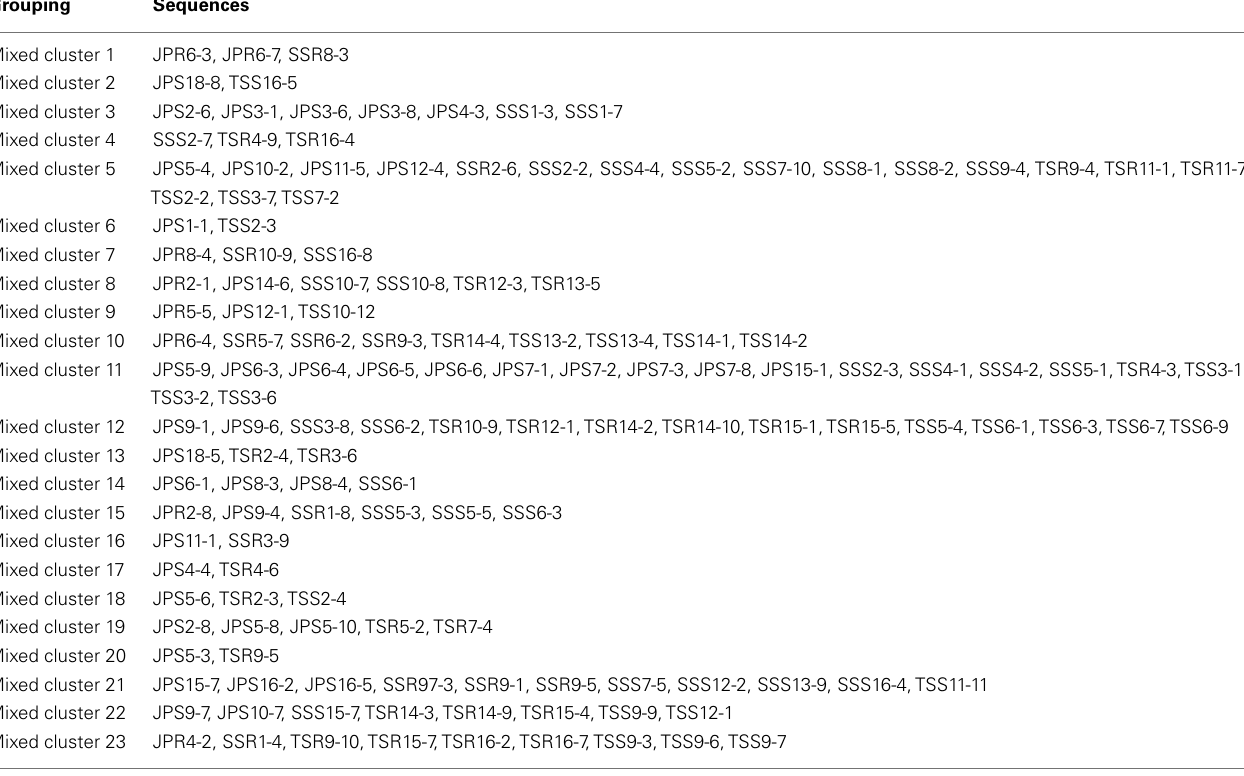
TableA3 | Sequences included in the mixed clusters designated in Figures 6 and